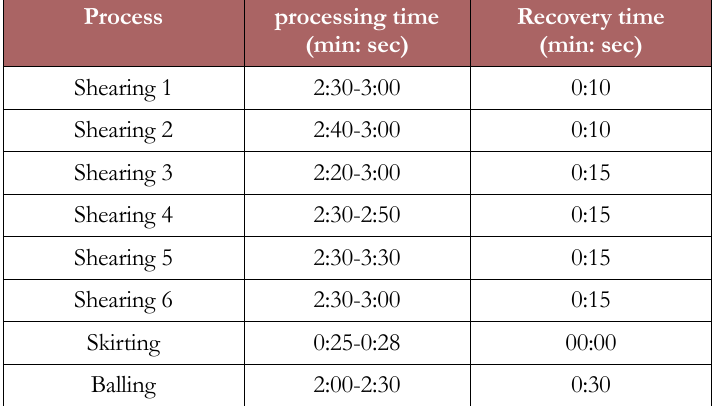
Table2. Processing and recovery time for shearing and skirting processes based on the collected data